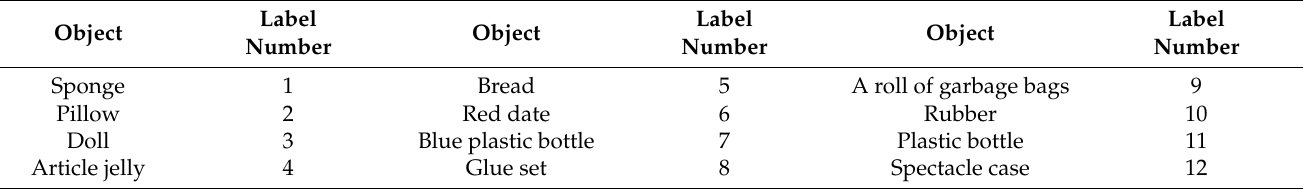
Figure 14. Confusion matrix of recognition results for the 12 object types, based on the five models. Table 3. The label numbers of the 12 object types.